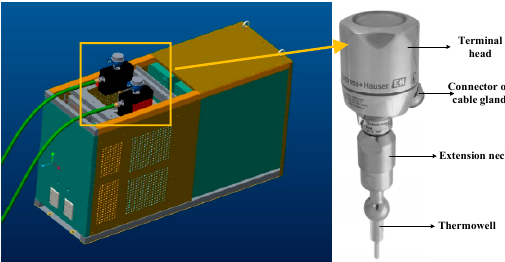
Figure 15. Position and configuration of the iTHERM TM411 thermometer applied in the press-pack stack.